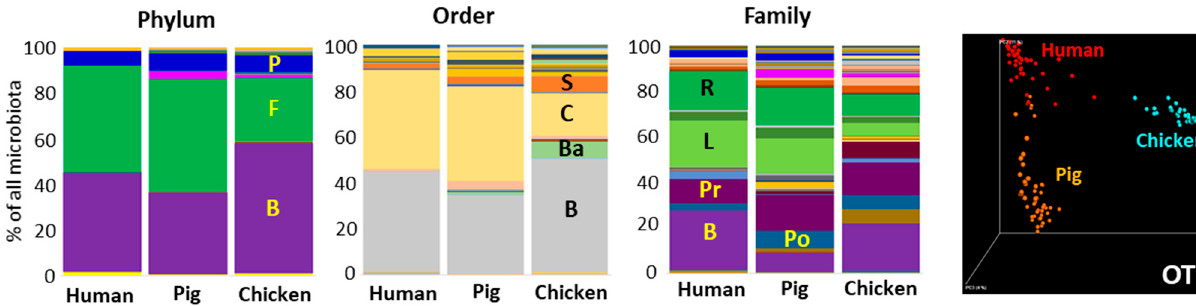
Figure 1. Composition of human, pig and chicken gut microbiota at selected taxonomic levels. Phy-